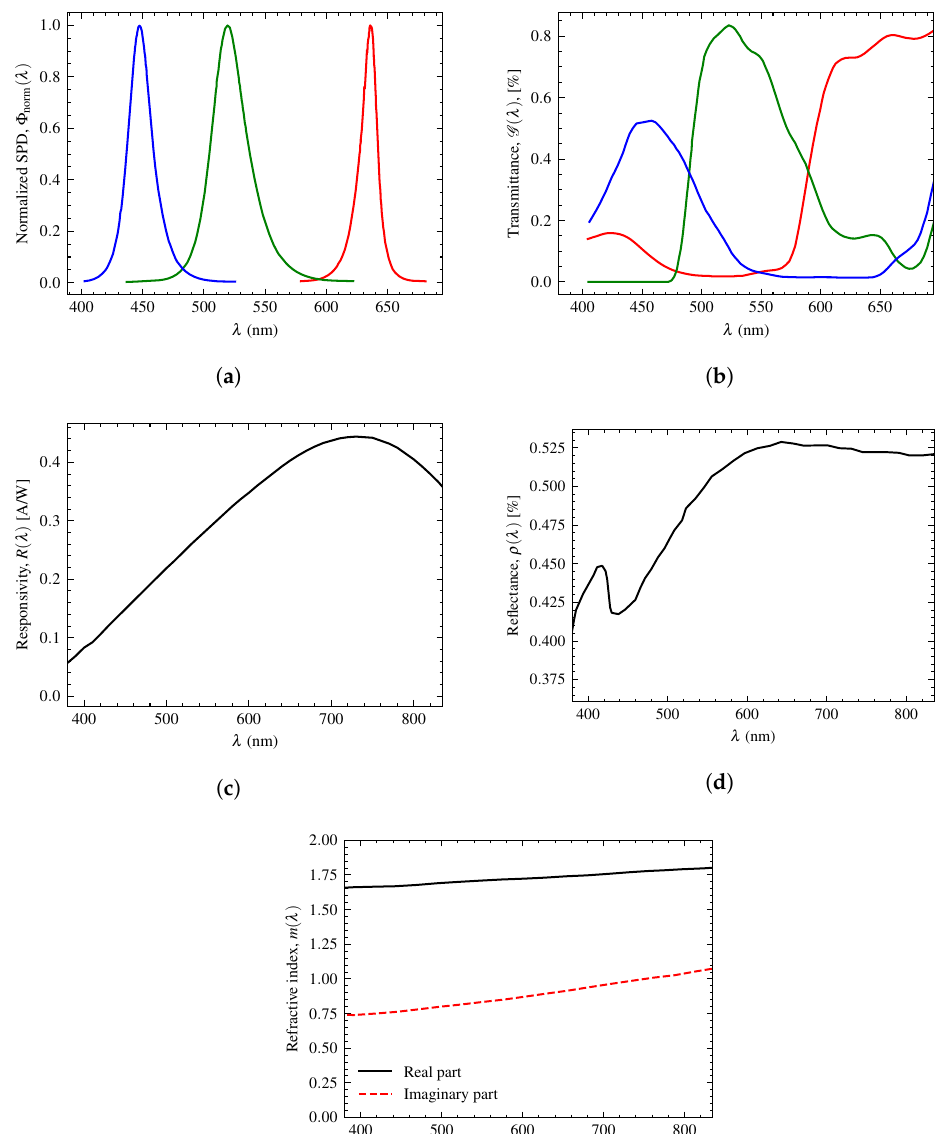
Figure 4. Spectral parameters used in this work: ( a ) Normalized SPDs of the red, green, and blue LEDs, Φ 1, norm , Φ 2, norm , Φ 3, norm ( λ ) (colored accordingly); data from [42]. ( b ) Transmittance of the ( λ ) (colored accordingly); data from [47]. ( c ) Responsivity red, green, and blue optical filters, , , G 1 G 2 G 3 of the PD, R ( λ ) ; data from [48]. ( d ) Tunnel wall reflectance, ρ ( λ ) ; data from [50]. ( e ) Refractive index of dust, m ( λ ) ; data from